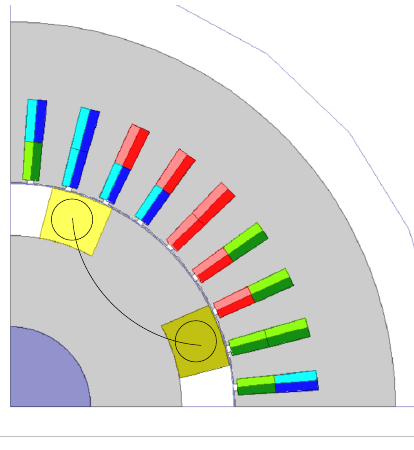
Figure 17. Design 4 (rotor radius: 74.4 mm).